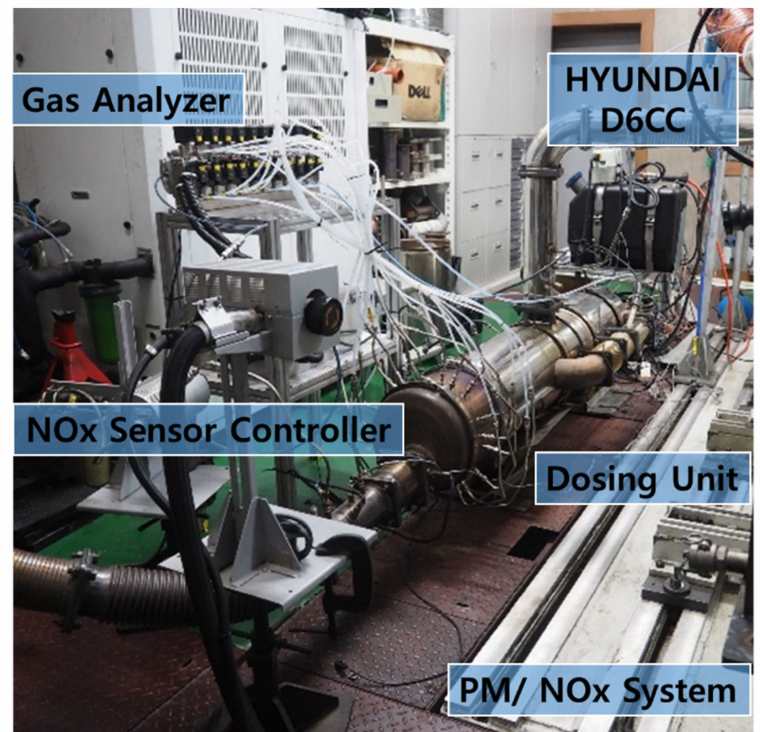
Figure 12. Experimental test and engine measurement